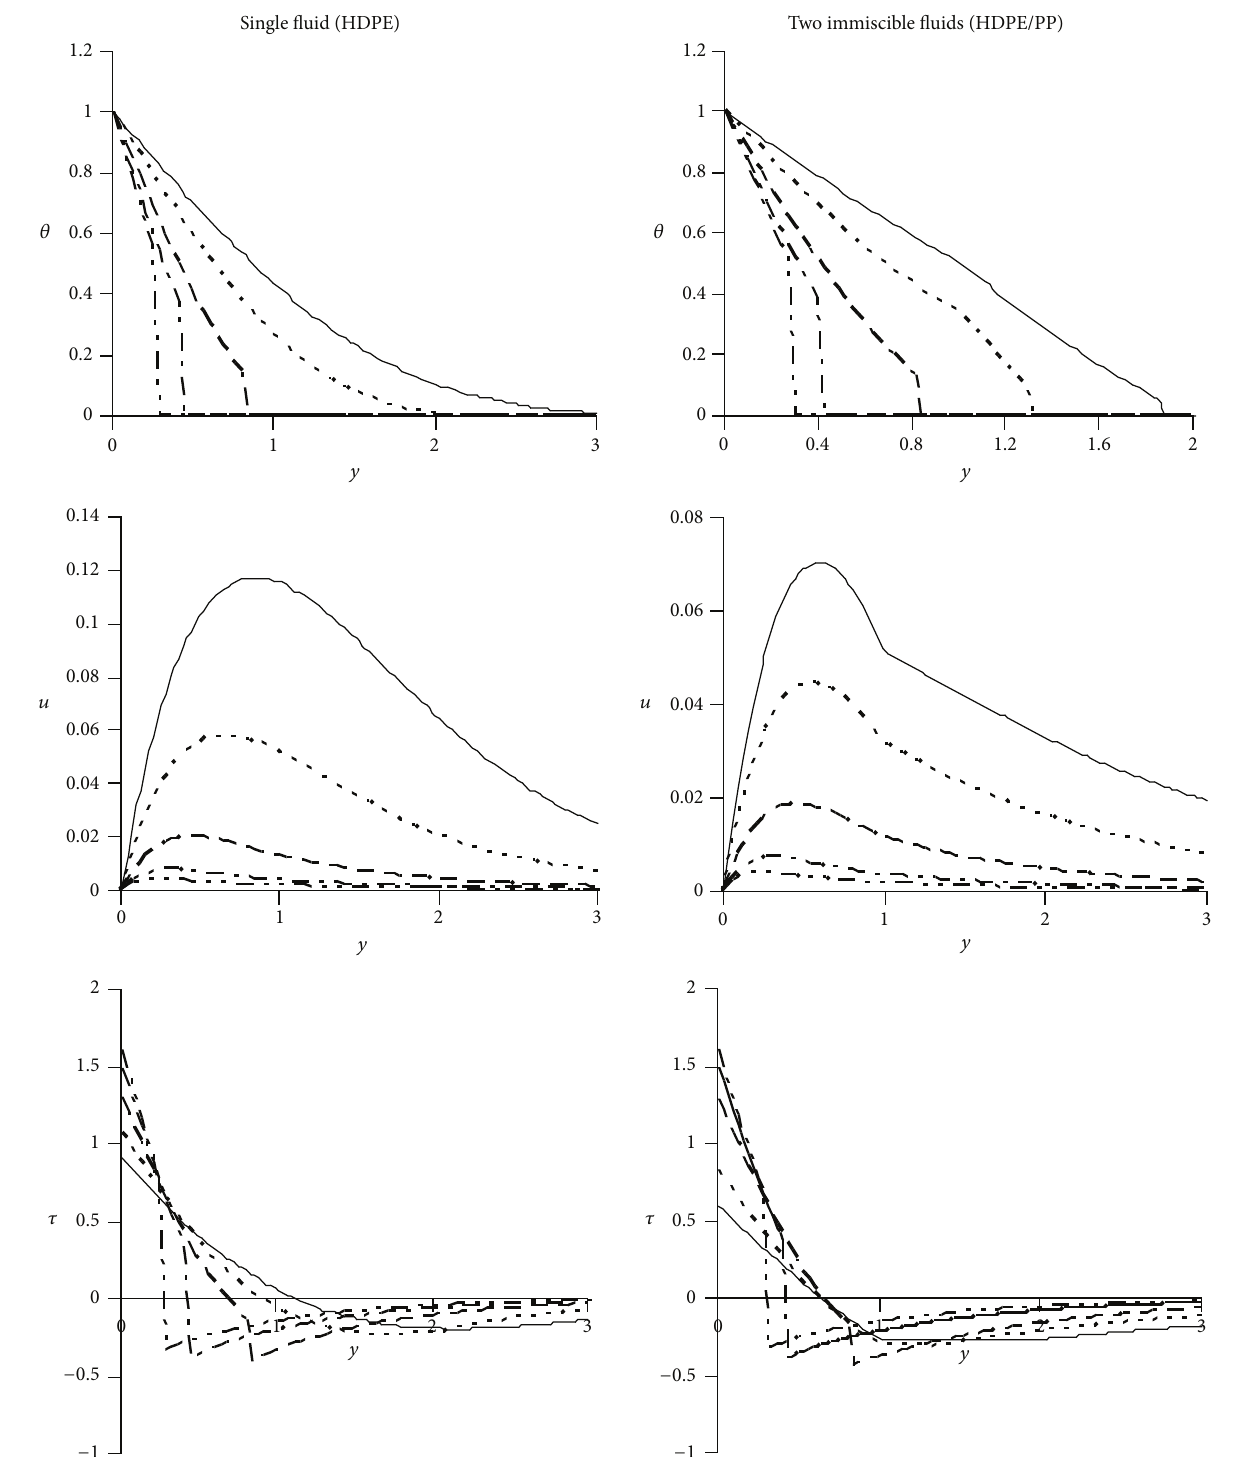
Figure 1: Temperature, velocity, and stress distribution for 𝛼 1 = 𝛼 2 = 𝛽 1 = 𝛽 2 = 1 and 𝑡 = { 0.02 (– ⋅ ⋅ –); 0.03 (– ⋅ –); 0.06 (–– –); 0.15 ( ⋅ ⋅ ⋅ ); 0.3 (— )}